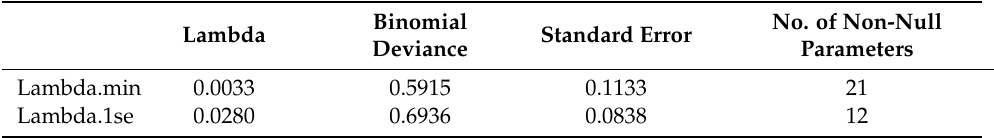
Table 5. Cross-validation